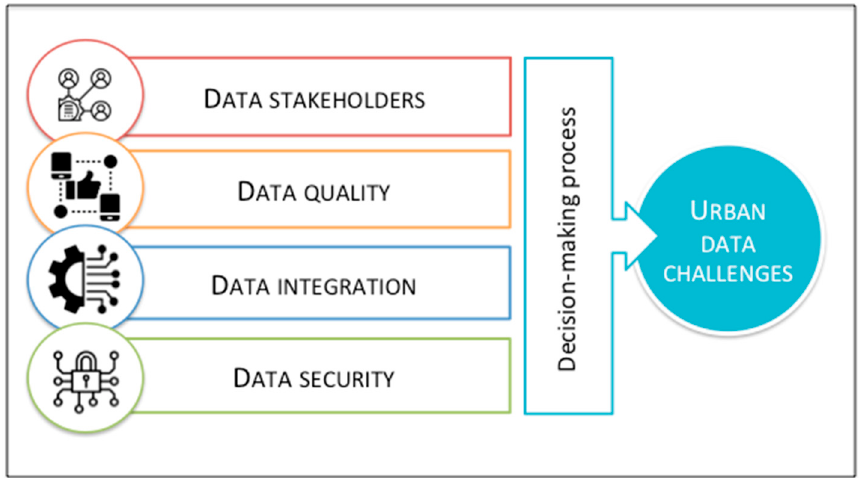
Figure 8. Future urban data challenges (source: authors).